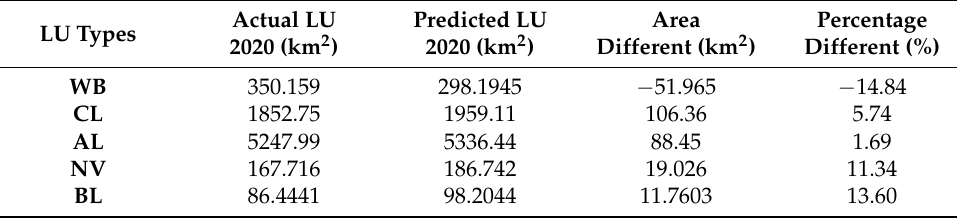
Table 8. Difference in area between the actual and predicted LUCC in